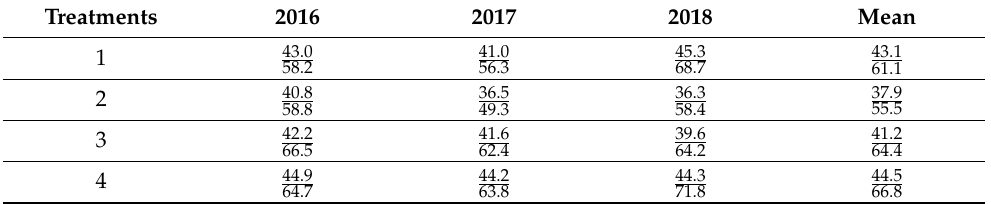
Table 6. Wheat grain yields (c/ha) for 3 years (above the line—grain; below the line—straw).